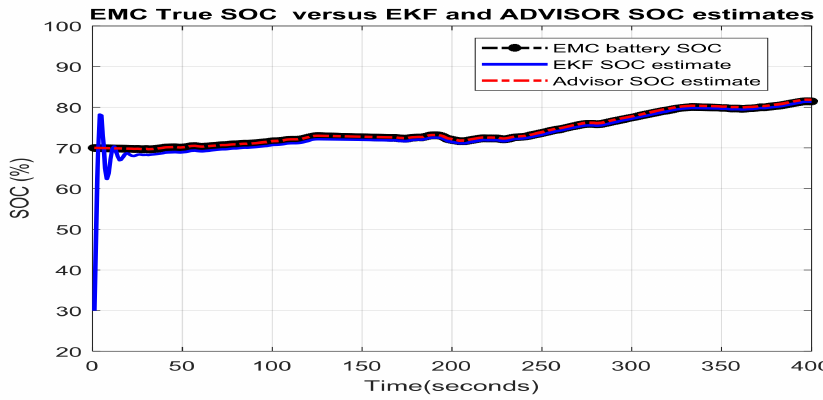
Figure 25. The 3RC EMC SOC model versus EKF SOC and ADVISOR SOC estimates for T = 15 ◦